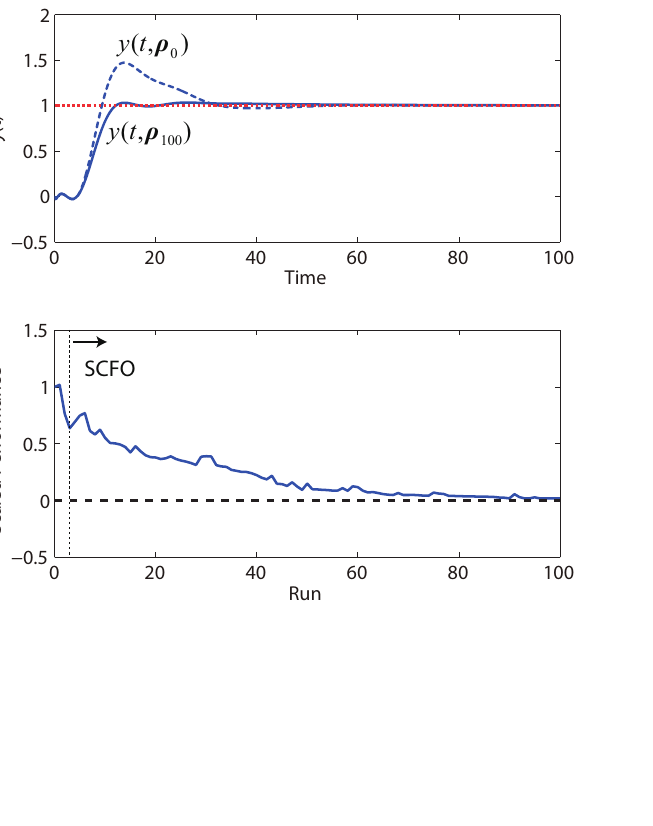
Figure 13. Performance obtained by iterative tuning for both the noiseless (left) and noisy (right) cases of Study 1 of Problem (20), with the solid blue line used to denote the “true” performance of the closed-loop system and the green dashed line used to denote what is actually observed (and provided to the solver). In both cases, the SCFO solver brings the closed-loop performance metric value close to its global minimum of zero (marked by the black dashed line in the lower